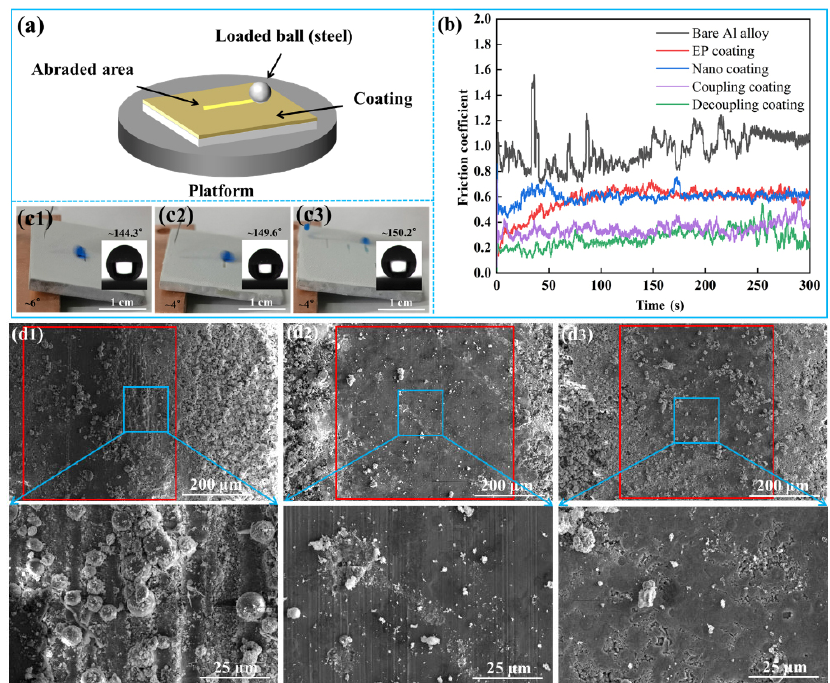
Fig. 7 (a) Schematic illustration of wear test for coating; (b) friction coefficients of bare Al alloy, EP, nano, coupling, and decoupling coatings; CAs and RAs of water on the (c1) nano, (c2) coupling, and (c3) decoupling coatings after wear test; and SEM images of (d1) decoupling, (d2) nano, and (d3) coupling coatings after wear